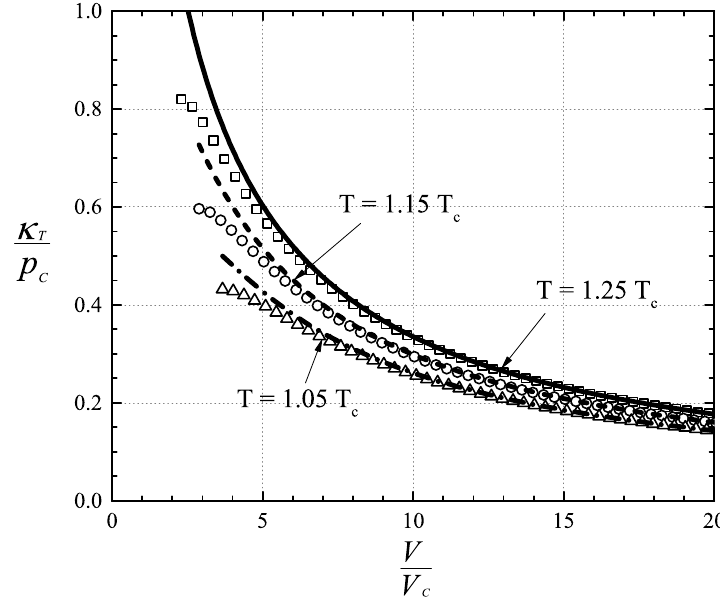
Figure 4. Scaled bulk modulus vs. V / V c at T = 1.25 T c , 1.15 T c , and 1.05 T c . The lines represent the exact bulk modulus obtained from the exact gas model (EGM) and Equation (1). The symbols denote the virial expansion of the bulk modulus computed using Equations (68) and